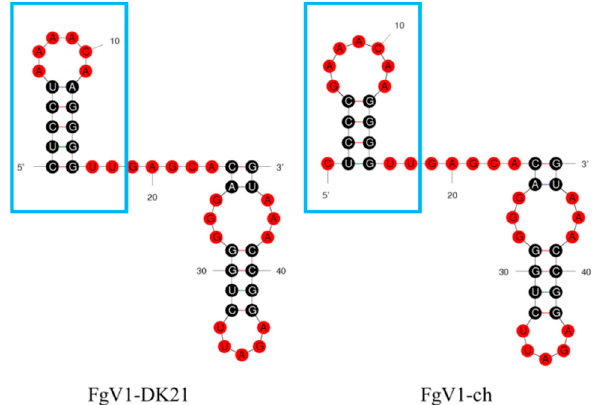
Figure 5. The predicted 3 ′ -UTR secondary structures of FgV1-ch and FgV1-DK21. These secondary structures both contain two Hairpin loops (FgV1-DK21, Initial Δ G = − 10.20 kcal/mol; FgV1-ch, Initial Δ G = − 10.10 kcal/mol. Ionic conditions: 1M NaCl, no divalent ions.). The different loops are labelled with blue square boxes.